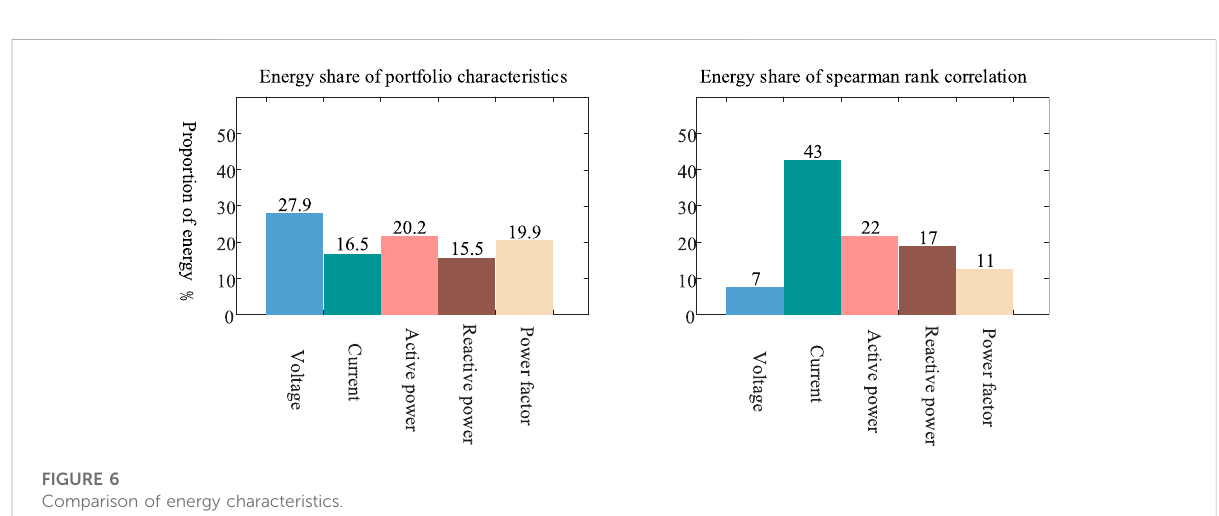
FIGURE 5 Energy share of the fi ve signals after decomposition.